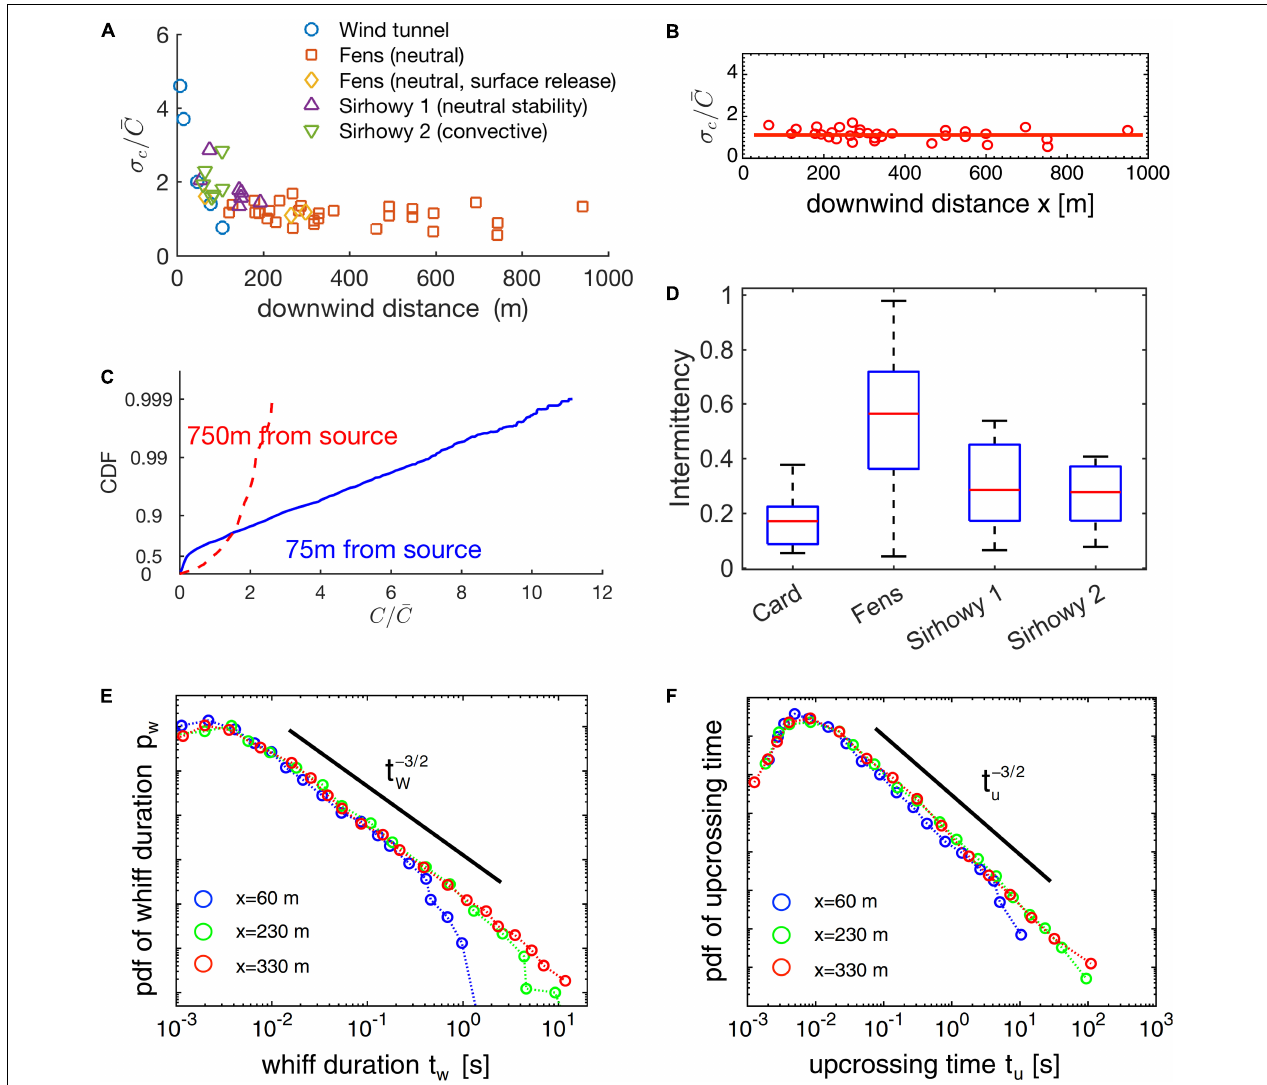
FIGURE 4 | Odor-landscape in the atmospheric boundary layer described by the statistics of its principal properties. (A) Fluctuation of odorant concentration σ C / C for several distances from the source and for several conditions (see Mylne and Mason, 1991). (B) Subset (“Fens” dataset) of data reported in (A) . (C) Cumulative distribution function of the concentration for two samples at 75 and 750 m distance from the source. (D) Probability distribution of intermittency for several locations. The theory can partially model the experimental results reported by Yee et al. (1995). (E,F) Probability distribution functions for whiff durations and upcrossing durations (data from Mylne and Mason, 1991; Yee et al., 1995). (B,C,F ) Reproduced from Celani et al. (2014), (A,C,D) reproduced from Mylne and Mason